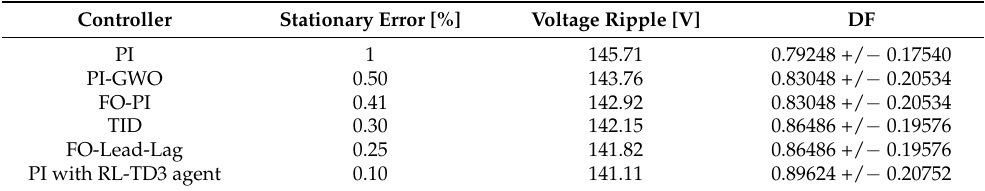
Table 2. Performance indicators of the V DC voltage control for UPQC-APF control system based on the presented